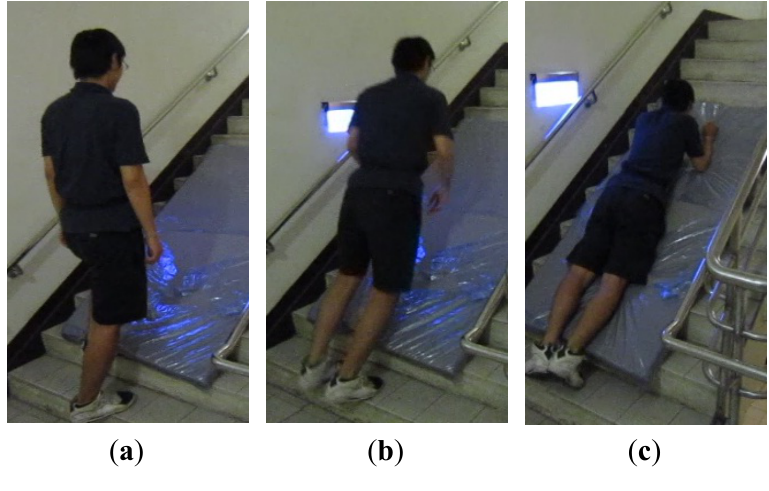
Figure 2. The sequence of images for the activity of slip when ascending